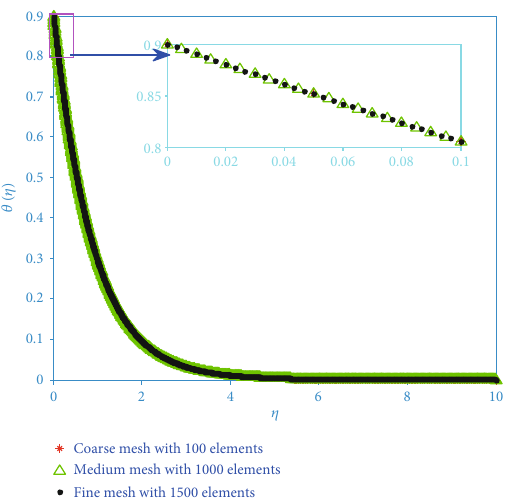
Figure 35: Grid-independence tests showing every fi fth element of the mesh for temperature pro fi le.